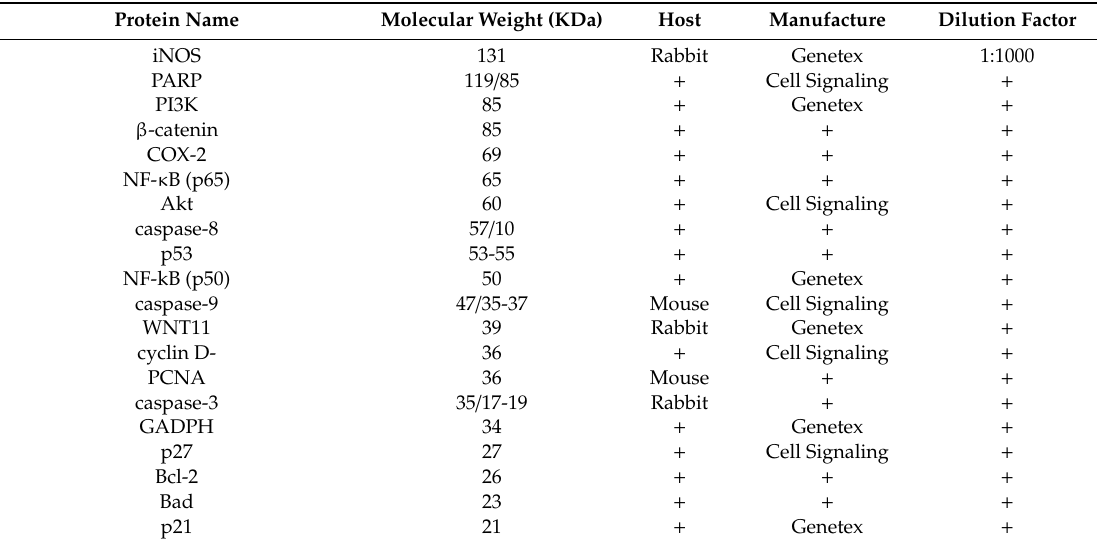
Table 1. Antibodies used in this